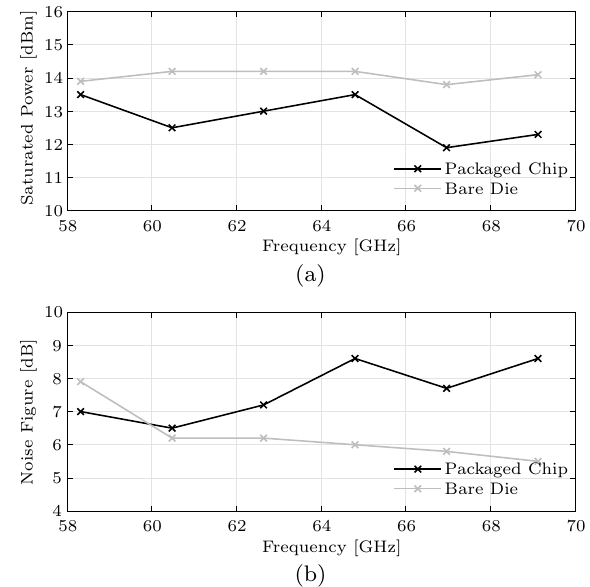
Fig. 10 Single-antenna path bare die vs packaged chip a compressed output power b noise